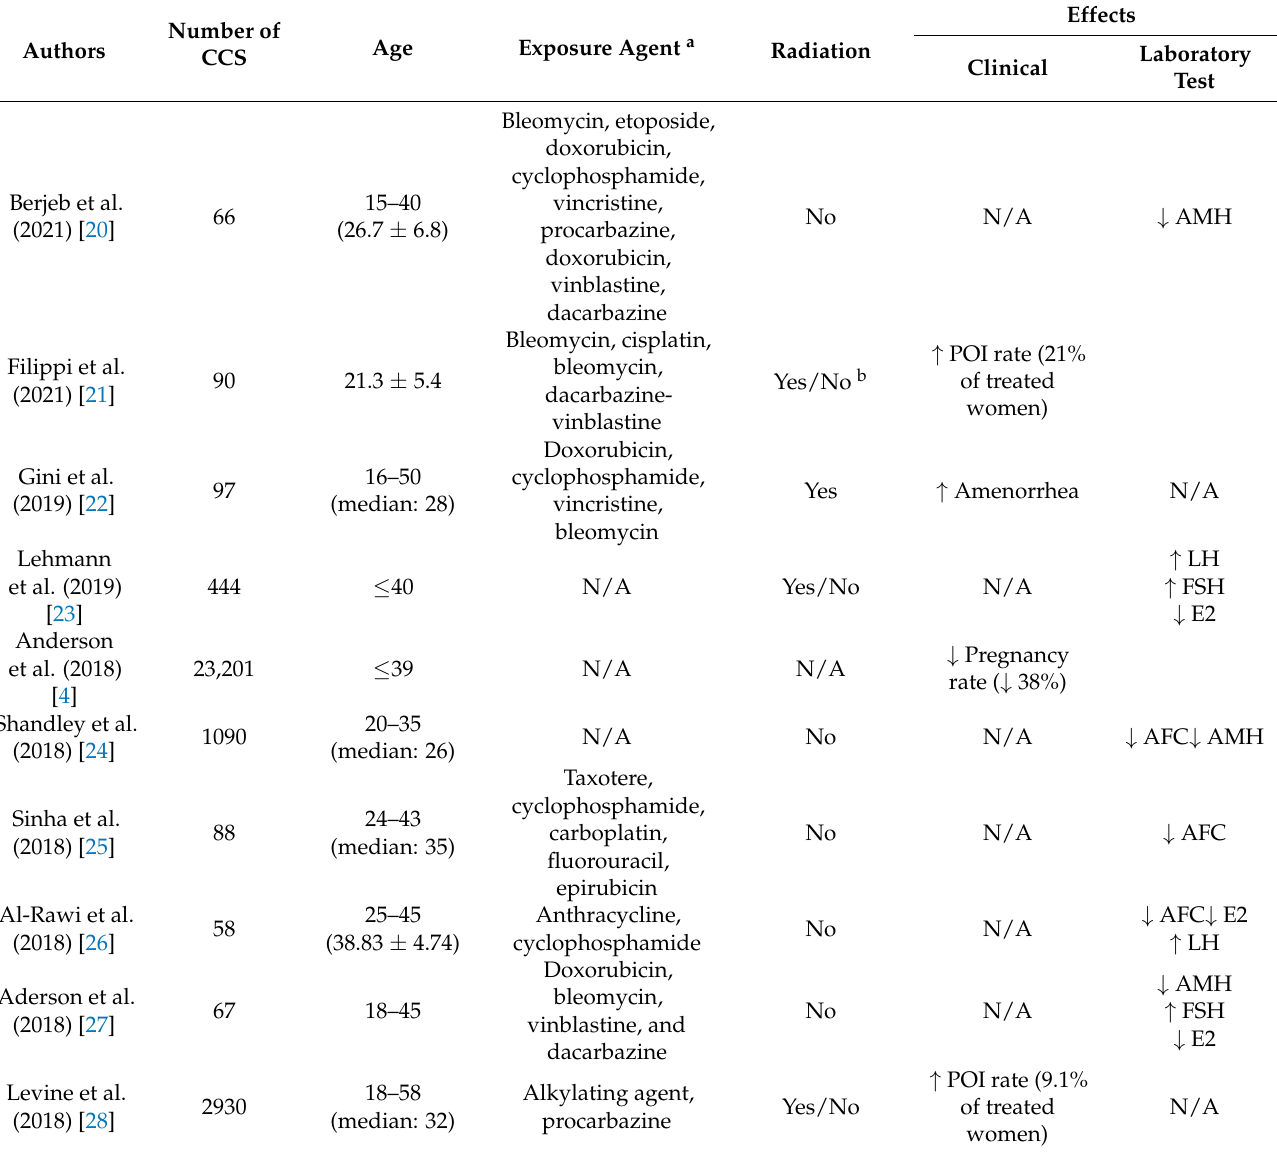
Table 1. Summary of published clinical studies describing chemo- and radio-therapy on ovarian function.